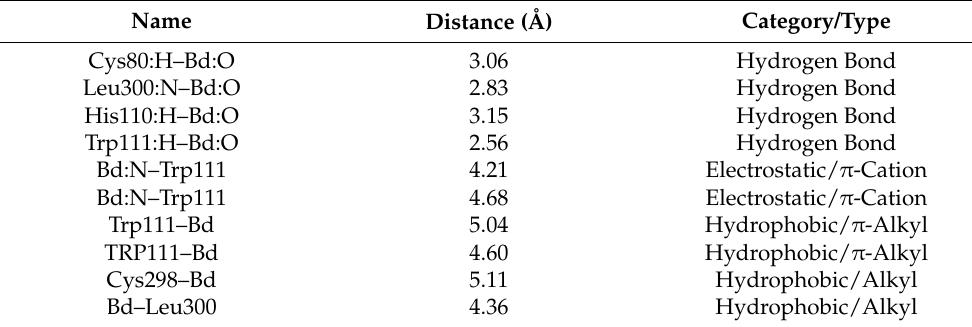
Figure 20. AR structure and molecular basis of potential active site interactions with Bd. Table 5. Interactions between Bd and the receptor